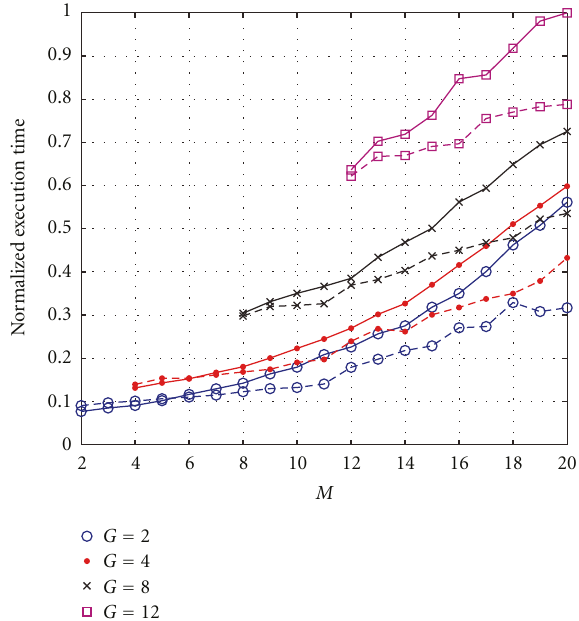
Figure 1: Normalized execution time of the original EVESPA (solid lines) and the proposed estimation procedure (dashed lines) in terms of M and G